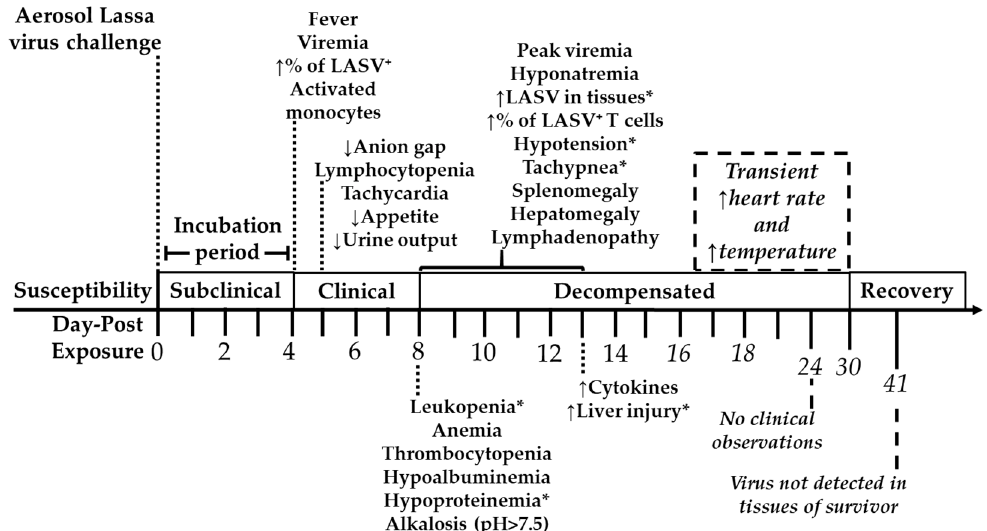
Figure 1. Natural history of aerosol induced Lassa virus infection of cynomolgus macaques. Subclinical stage of disease progression is marked by mean clinical score of zero from the day of challenge until presentation of fever and virus (day-post exposure, DPE 0–3). Clinical stage of infection involved detection of fever and virus (DPE 4–7). Further trend of viral glycoprotein-positive activated monocytes on DPE 4 as well as low anion gap, tachycardia, lymphocytopenia, decrease appetite and urine output on DPE 5. Decompensated stage (DPE 8–30) was identified with mean clinical score ≥ 0.4, peak viremia, alkalosis with blood pH > 7.5, and elevated serum levels of liver and kidney function markers. Leukopenia, anemia, thrombocytopenia, hypoalbuminemia, and hypoproteinemia were observed by DPE 8. Soluble oxygen percentage and mean arterial pressure are substantially decreased in comparison to prior time points. Peak viremia was followed by mild IFN γ response. On DPE 12–13, robust cytokine responses were associated with significant increased number of white blood cells, biochemical liver injury markers, and blood urea nitrogen levels. The decompensated stage included random display of posture and appearance as well as impairment of neurological function, hepatomegaly, splenomegaly, and lymphadenopathy. The survivor experienced transient increase in heart rate and temperature within DPE 25–29. Recovery stage (Post-DPE 30) was establishing based on mean clinical score of zero for eleven days, viremia below 100 PFU / mL, blood pH < 7.5, and liver and kidney functions markers near baseline levels. * Asterisks marks exception of one animal.